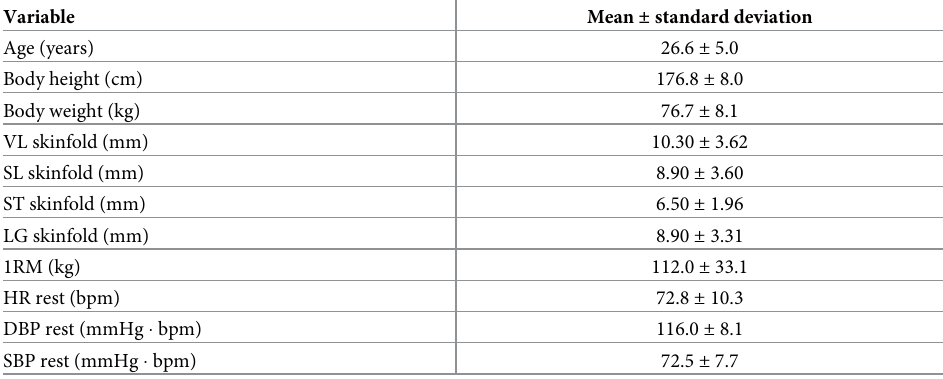
Table 1. Physical and physiological characteristics of the participants (n =